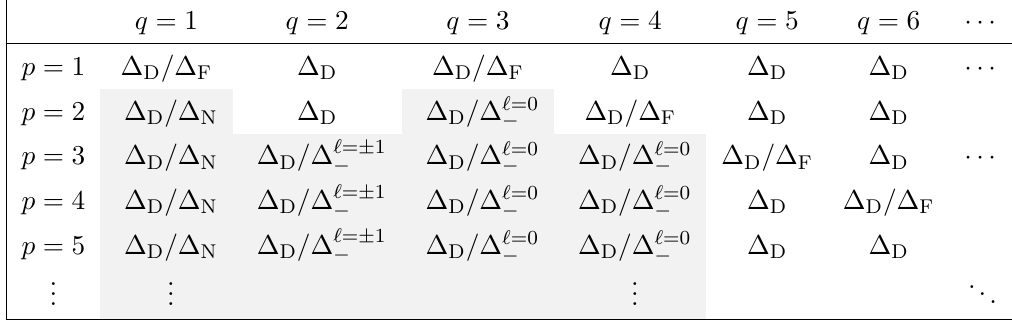
Table 1 . Classification of the allowed boundary conditions in the free scalar theory. The Neumann boundary conditions exist in the shaded cells and the allowed modes differ from the Dirichlet ones are shown in the right side. Our table is the same as the classification of the non-monodromy defects in [59] except that ours has additional column for q = 1 and boundary conditions ∆ ‘ = ± 1 for q = 4 and p ≥ 3 saturating the unitarity bound. The free boundary q = 2 and p ≥ 3 , and ∆ ‘ =0 − condition appears when p = q = 1 and q = p + 2